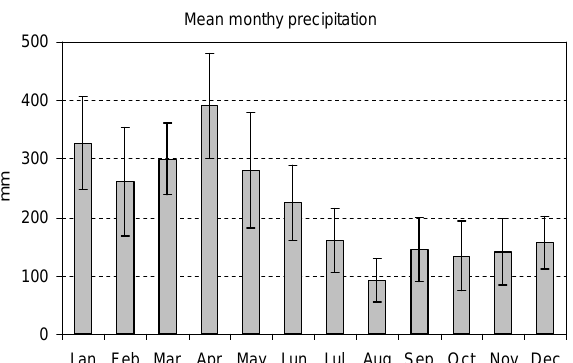
Fig. 2. Average monthly precipitation in the Balbina region during the period 1998–2001. Data were obtained from four hydrological stations operated by the Brazilian National Water Agency (http:// hidroweb.ana.gov.br). Error bars correspond to standard deviation of